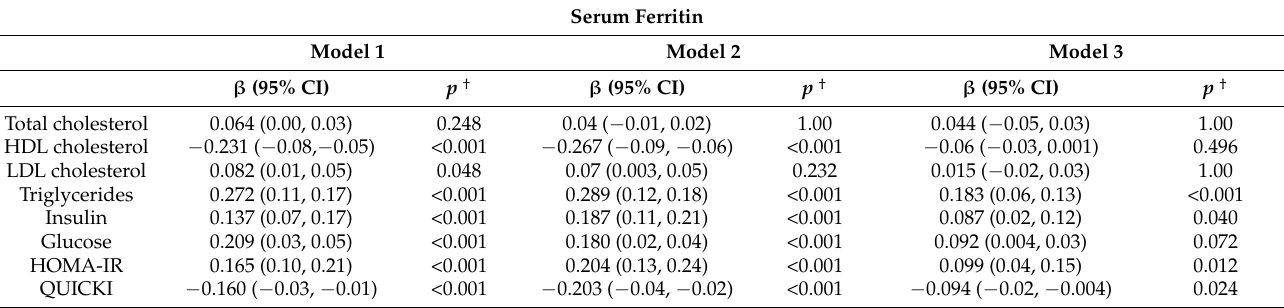
Table 4. Adjusted linear regression analysis of relationship between serum ferritin and metabolic health parameters.